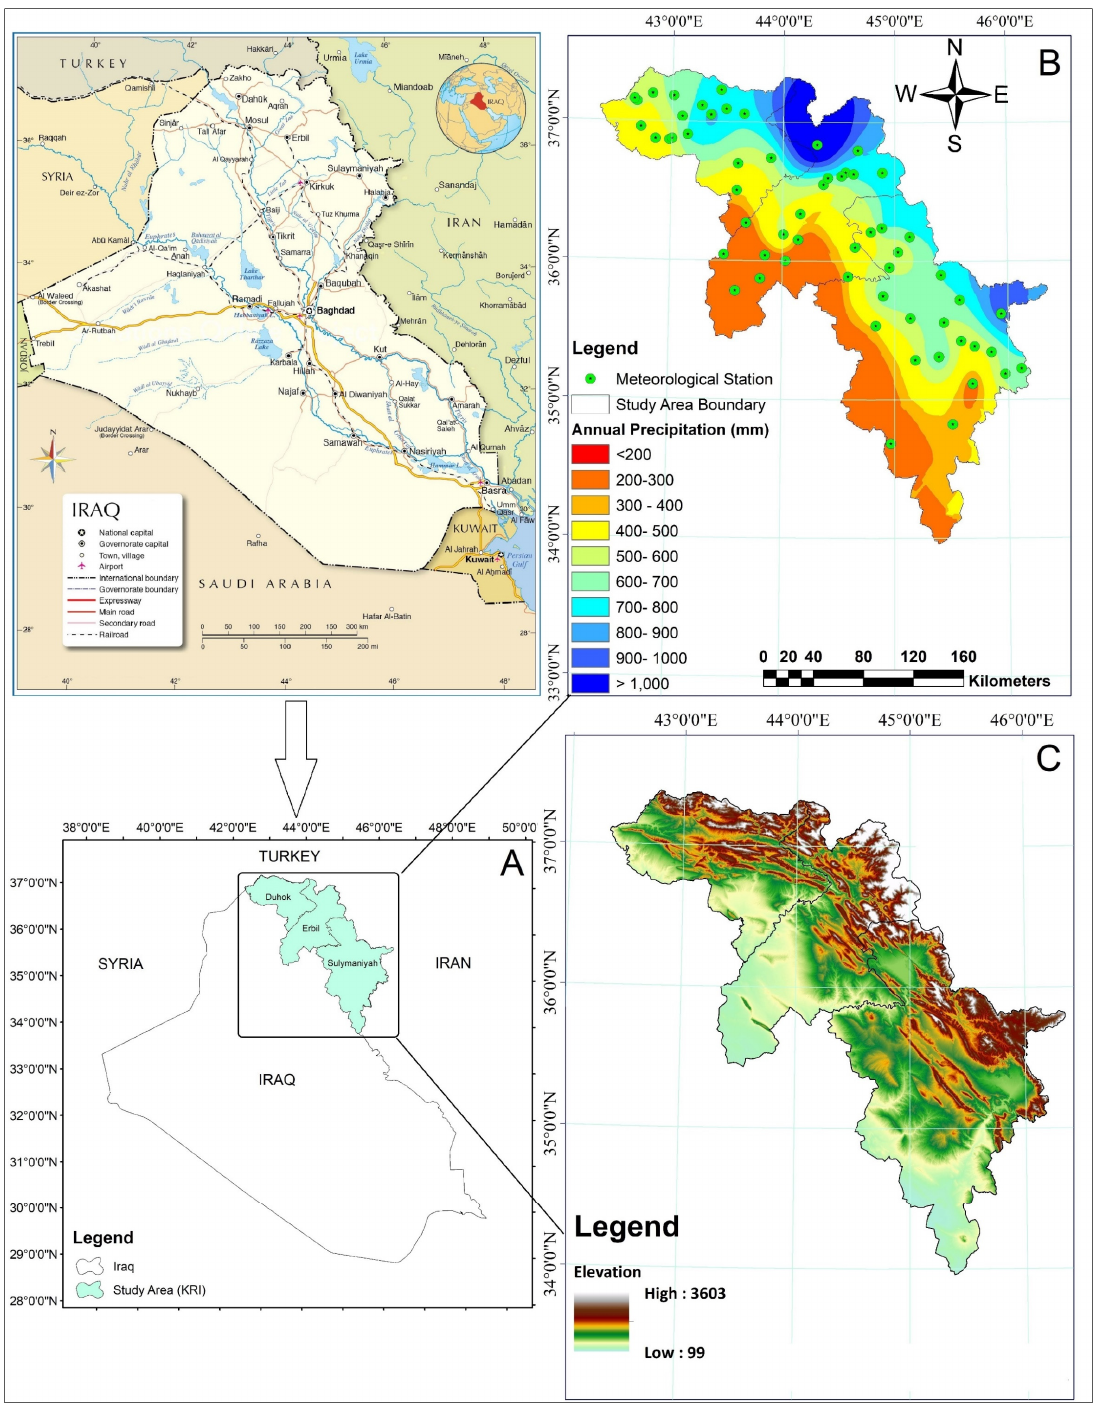
Figure 1. ( A ) Location map of the study area ( B ); The meteorological stations map and the spatial distri- bution of annual rainfall (mm/year) in the KRI in 1998–2017 ( C ); Digital Elevation Model (DEM).